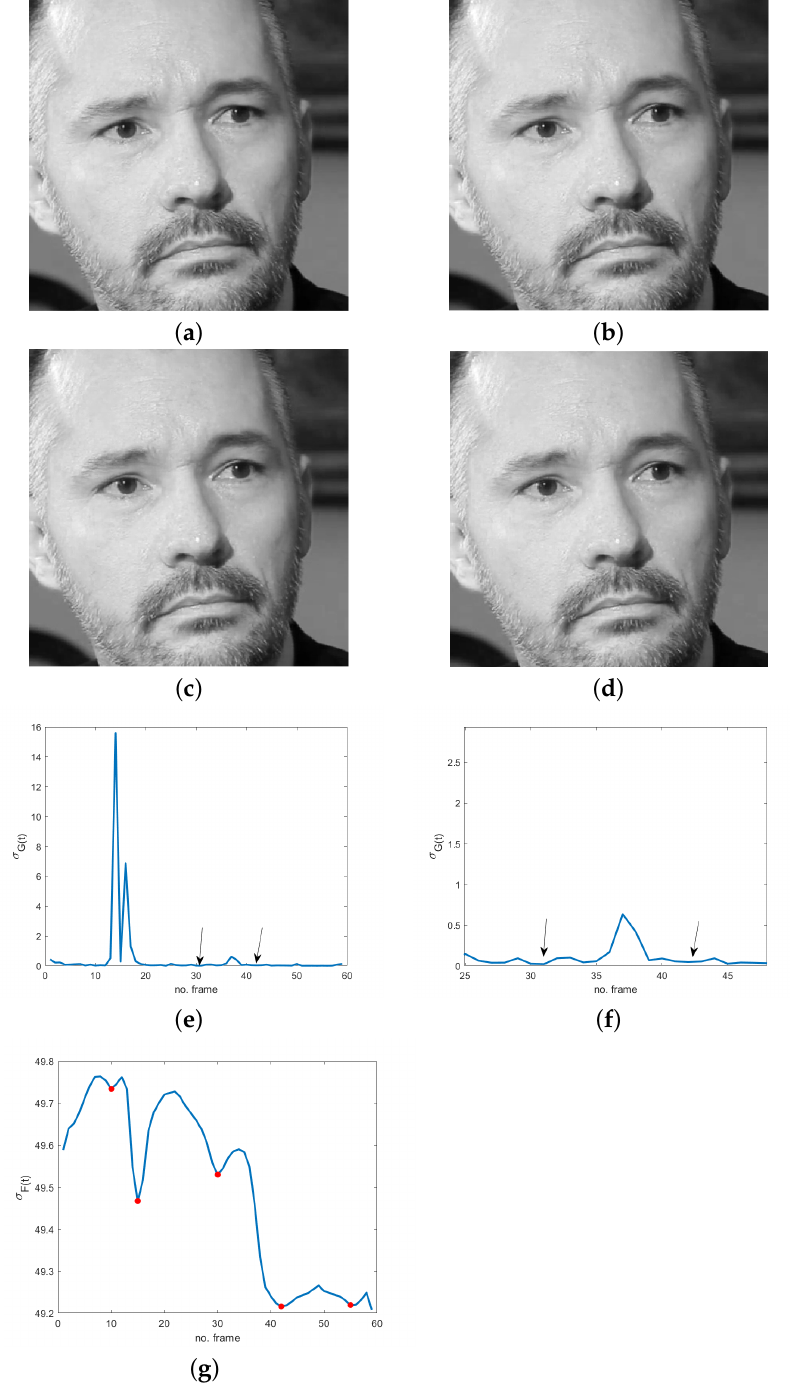
Figure 2. Four frames of the sequence cut 15.1 in the MEVIEW dataset [38]: ( a ) frozen frame before a microexpression (ME) ( surprise); ( b ) ME onset; ( c ) ME apex; ( d ) frozen frame after ME; ( e ) temporal global energy measured as the standard deviation of the spatio-temporal filtered sequence using the filter in Equation (1)—the arrows indicate frozen frames; ( f ) standard deviation restricted to the group of frames containing the ME; ( g ) standard deviation of the spatio-temporal filtered sequence using the filter l ( x , y , t ) in Equation (2) restricted to the group of frames containing a ME—markers correspond to local